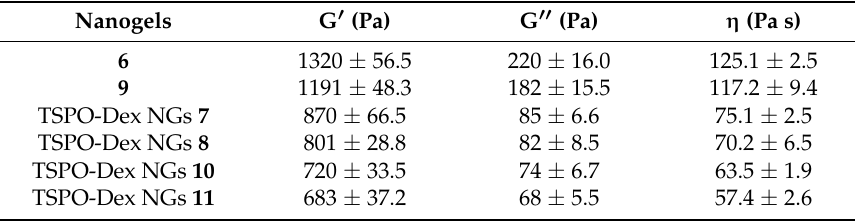
Table 5. Rheological results of TSPO-Dex NGs.